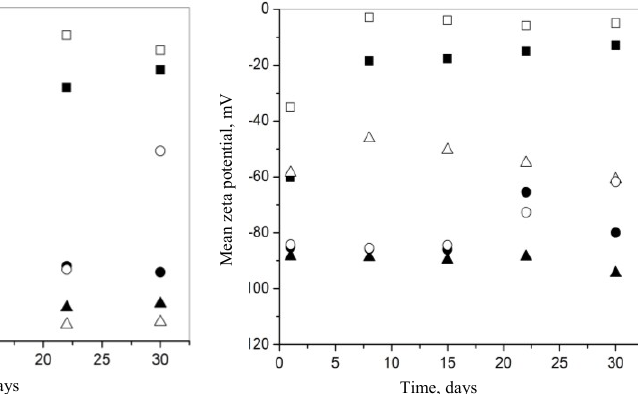
Figure 6. Mean zeta potential at pH 7.5 (■, □), 8.5 (▲, △ ) and 9 (●, ○) of linolenate -linolenic acid vesicle (filled symbol) and PEGylated linolenate-linolenic acid vesicle (empty symbol).